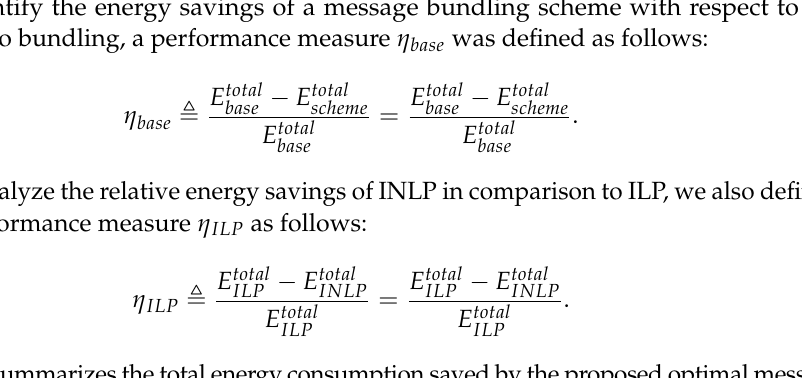
Figure 5. Total power consumption based on Equation